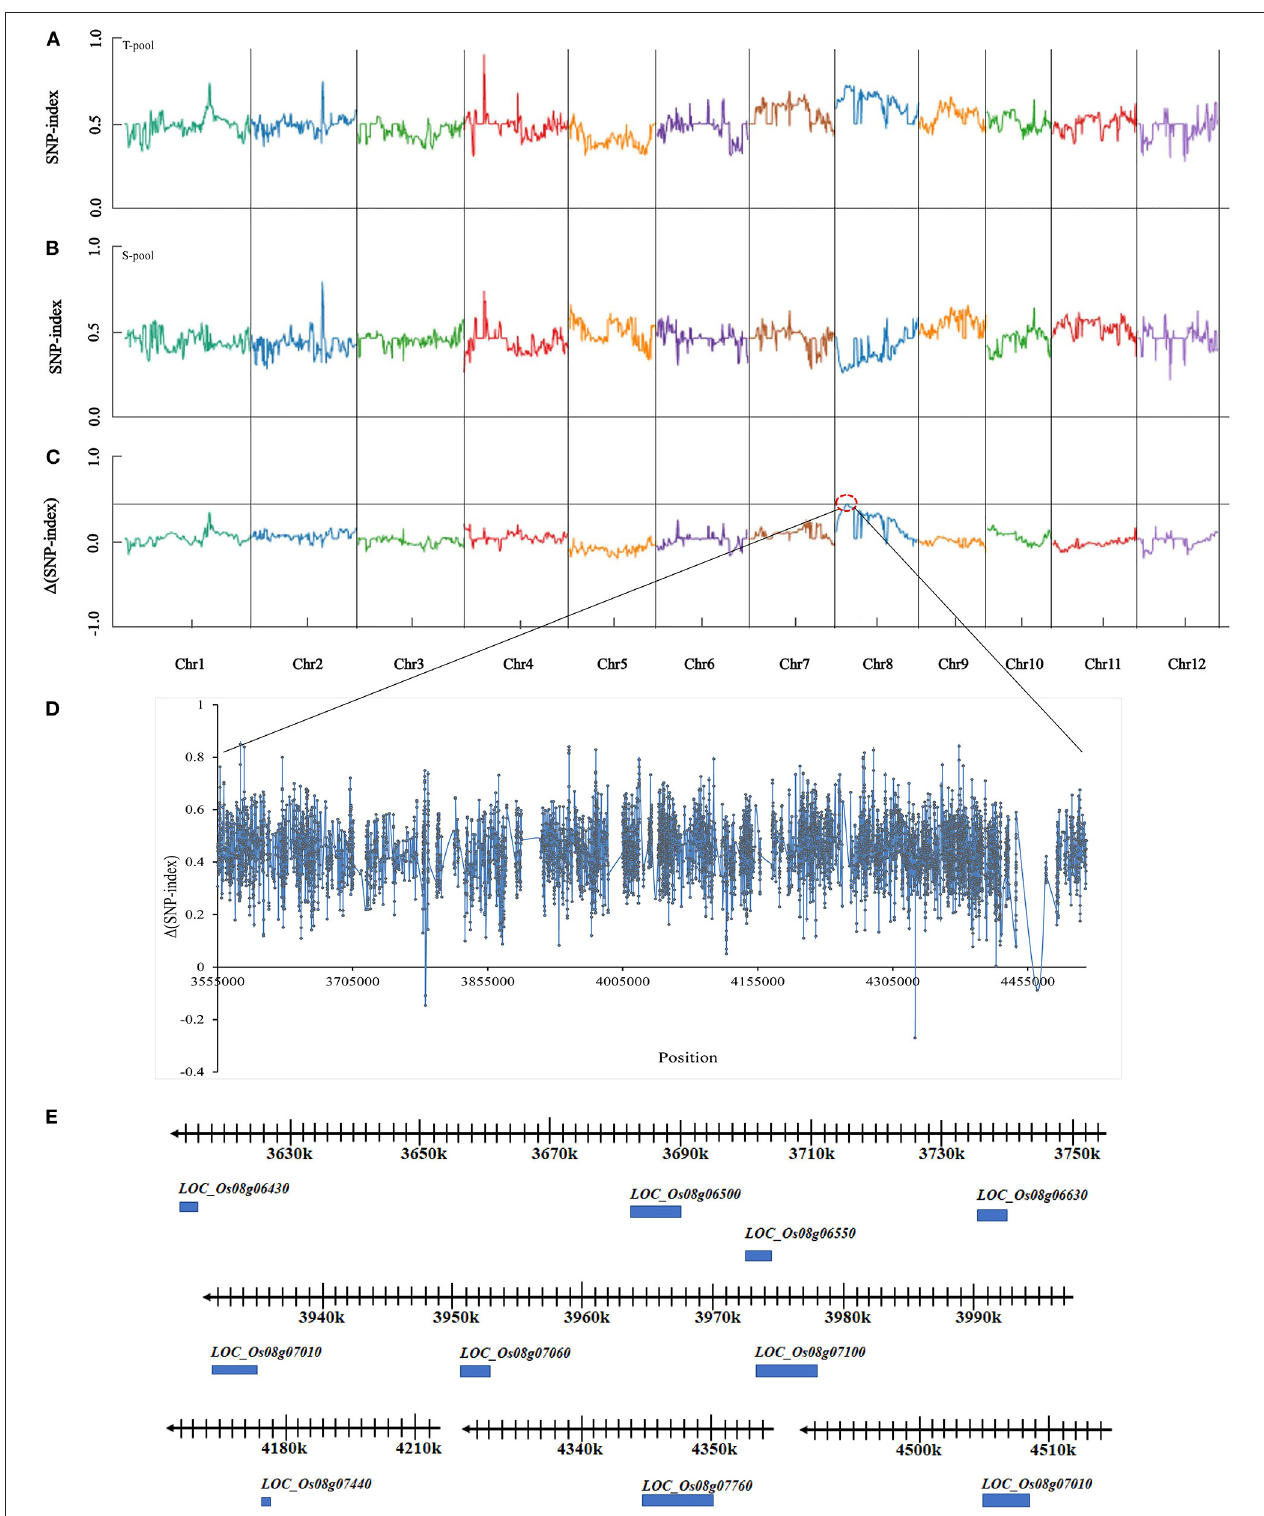
FIGURE 2 | SNP-index graphs of T-pool (A) , S-pool (B) , and 1 (SNP-index) graph (C) from BSA-seq analysis. X-axis represents the position of the 12 chromosomes in rice; Y-axis represents the SNP-index. The black line shows the association threshold at a 99.9% confidence level (C) . HT major QTL is located to chromosome 8 (red dotted box). (D) Value of 1 (SNP-index) in the candidate region. (E) Physical location on chromosome 8 of the ten putative genes.